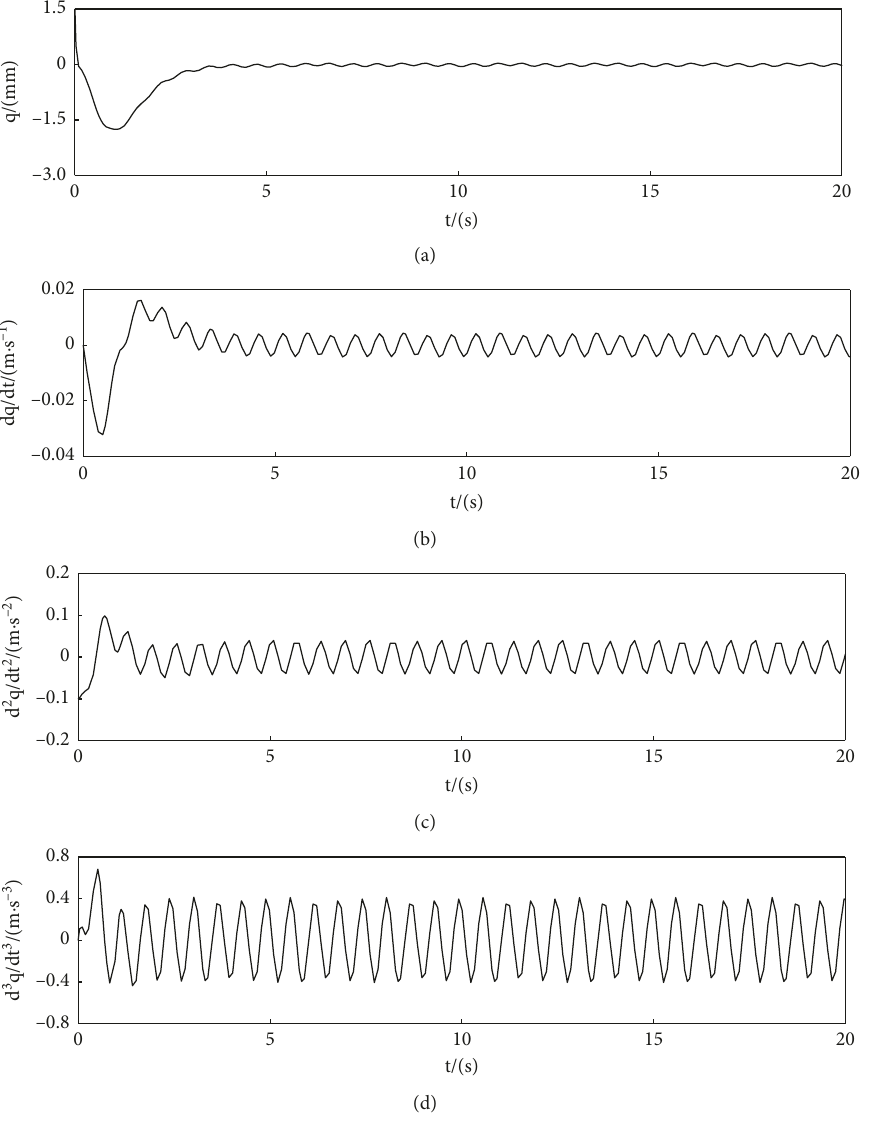
Figure 5: Response curve with control using sliding mode control method.